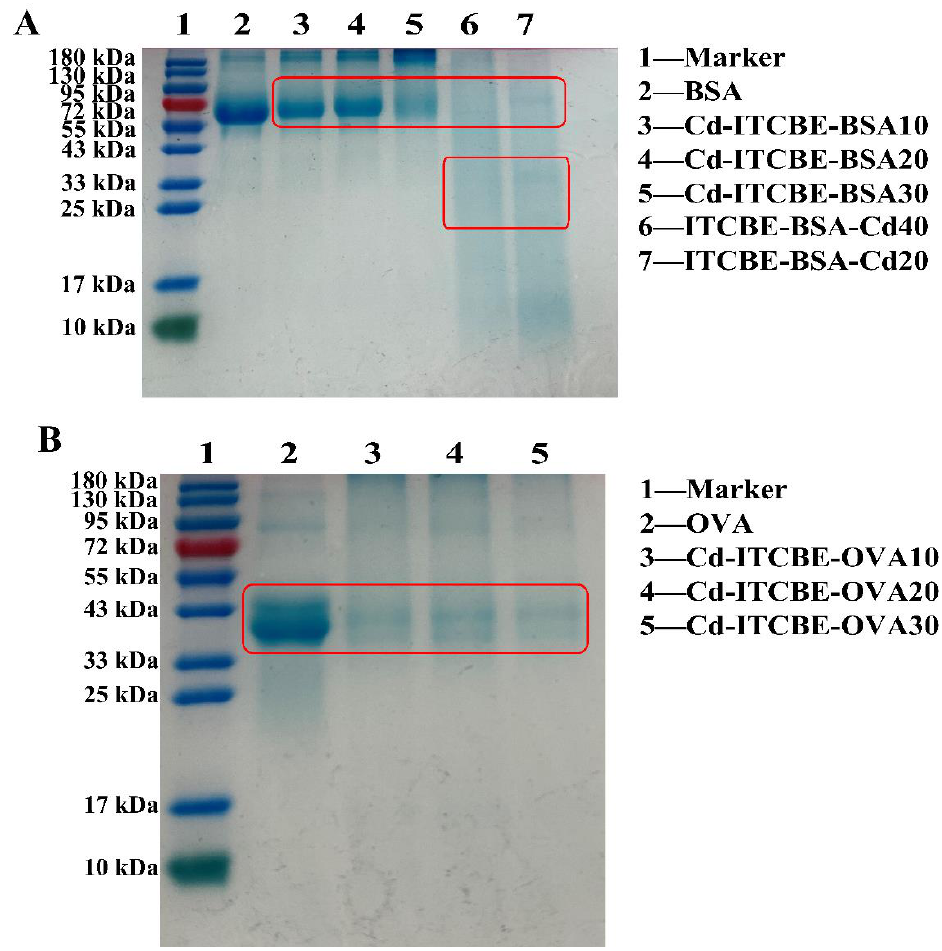
Figure 3. Complete antigens for Cd 2+ were identified by SDS-PAGE. ( A ) The immune antigens against Cd 2+ based on BSA; ( B ) Coating antigens for Cd 2+ based on